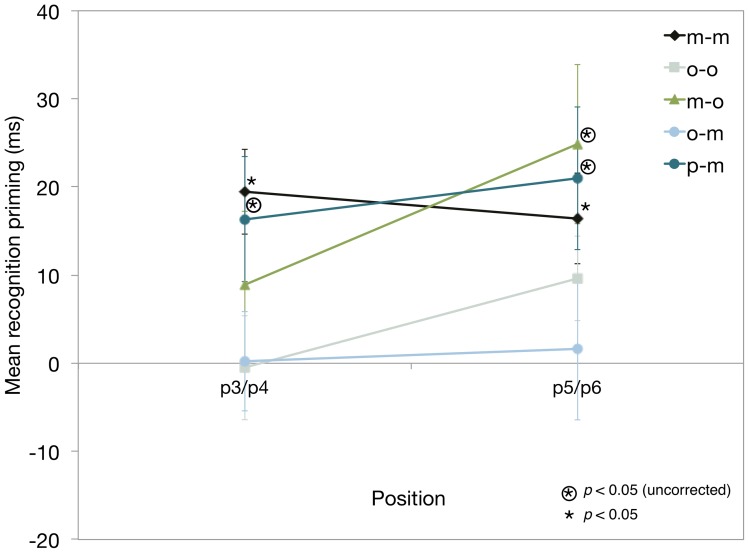
Response priming on the recognition tests that were administered in the baseline and transfer conditions (experiments 1 and 2).The difference in response latencies associated with the six-element studied and nonstudied recognition probes was used to measure priming. Mean response latencies (RTs or saccade latencies) to studied and nonstudied recognition sequences at positions 3–6 (predictable positions) are shown – position 3 represents the earliest point at which the (second-order conditional) response context can induce priming. Mean recognition priming scores provide an indirect (procedural) test of sequence knowledge (latencies associated with responses to studied positions subtracted from the corresponding RTs to nonstudied positions). Results are combined and presented for collapsed “early” 3–4 (p3/p4) and “late” 5–6 (p5/p6) positions.